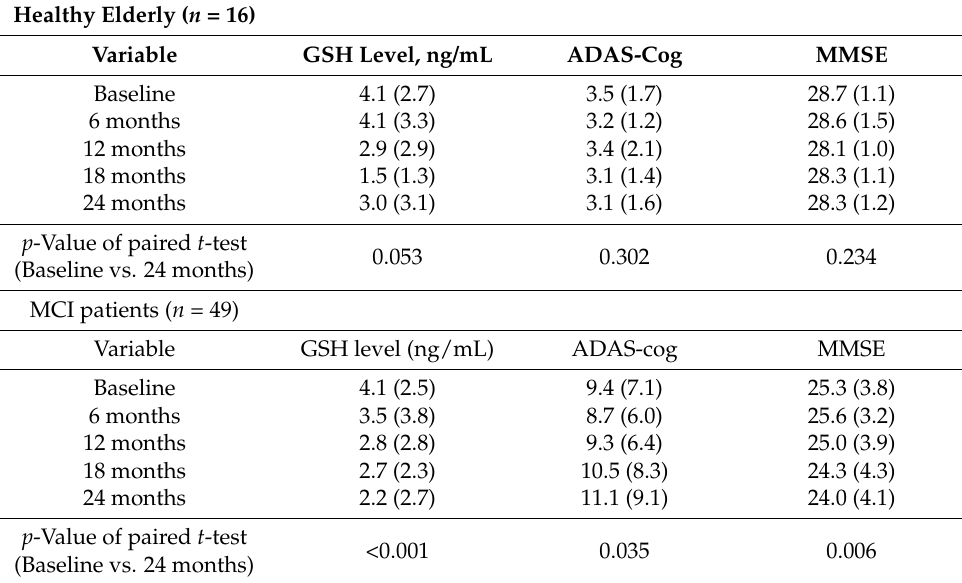
Table 2. The changes in GSH level and cognitive function during the 2 years